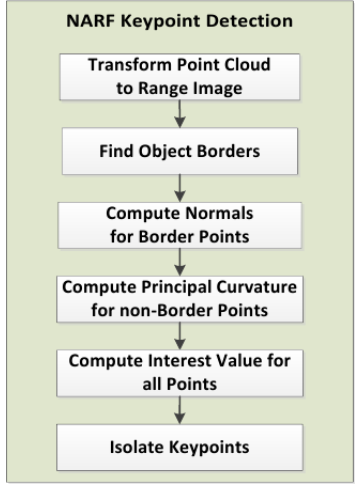
Figure 3: NARF keypoint computation Figure 3 shows the major steps of the NARF keypoint